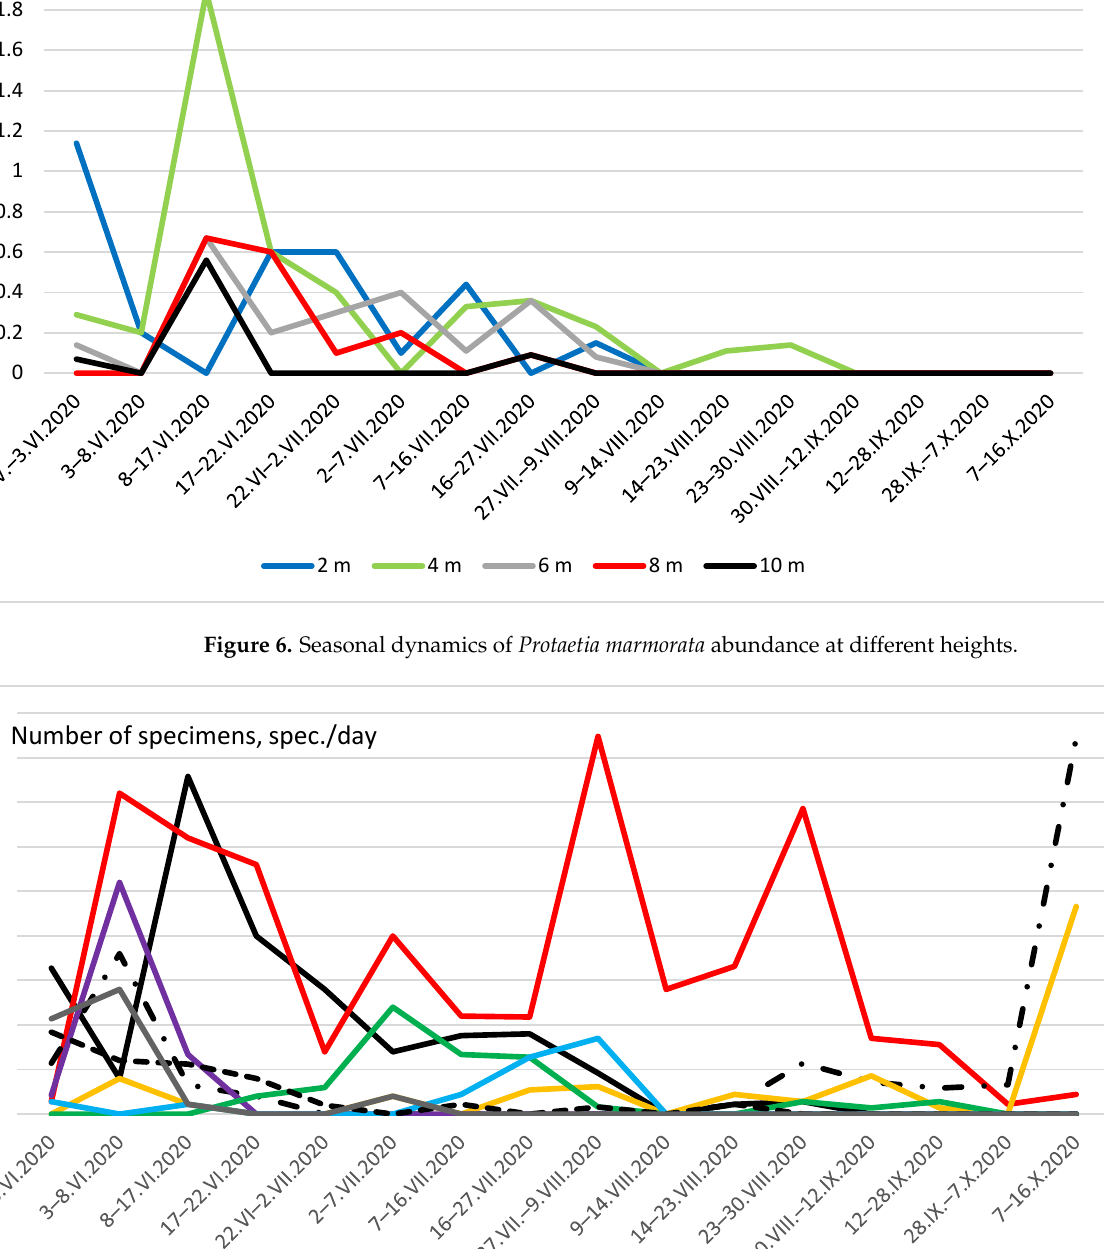
Figure 7. The total seasonal dynamics of the number of nine Coleoptera taxon in a glade in the forest.